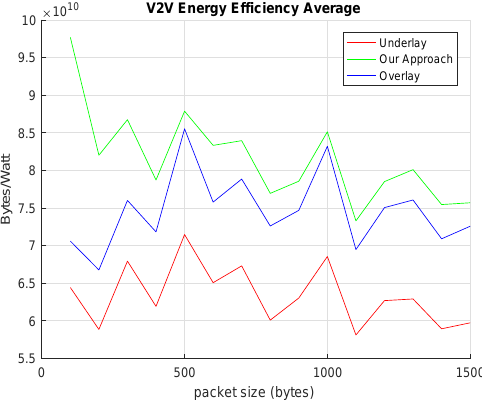
Figure 4. Performance of V-UEs according to the type of traffic in the C-EU.